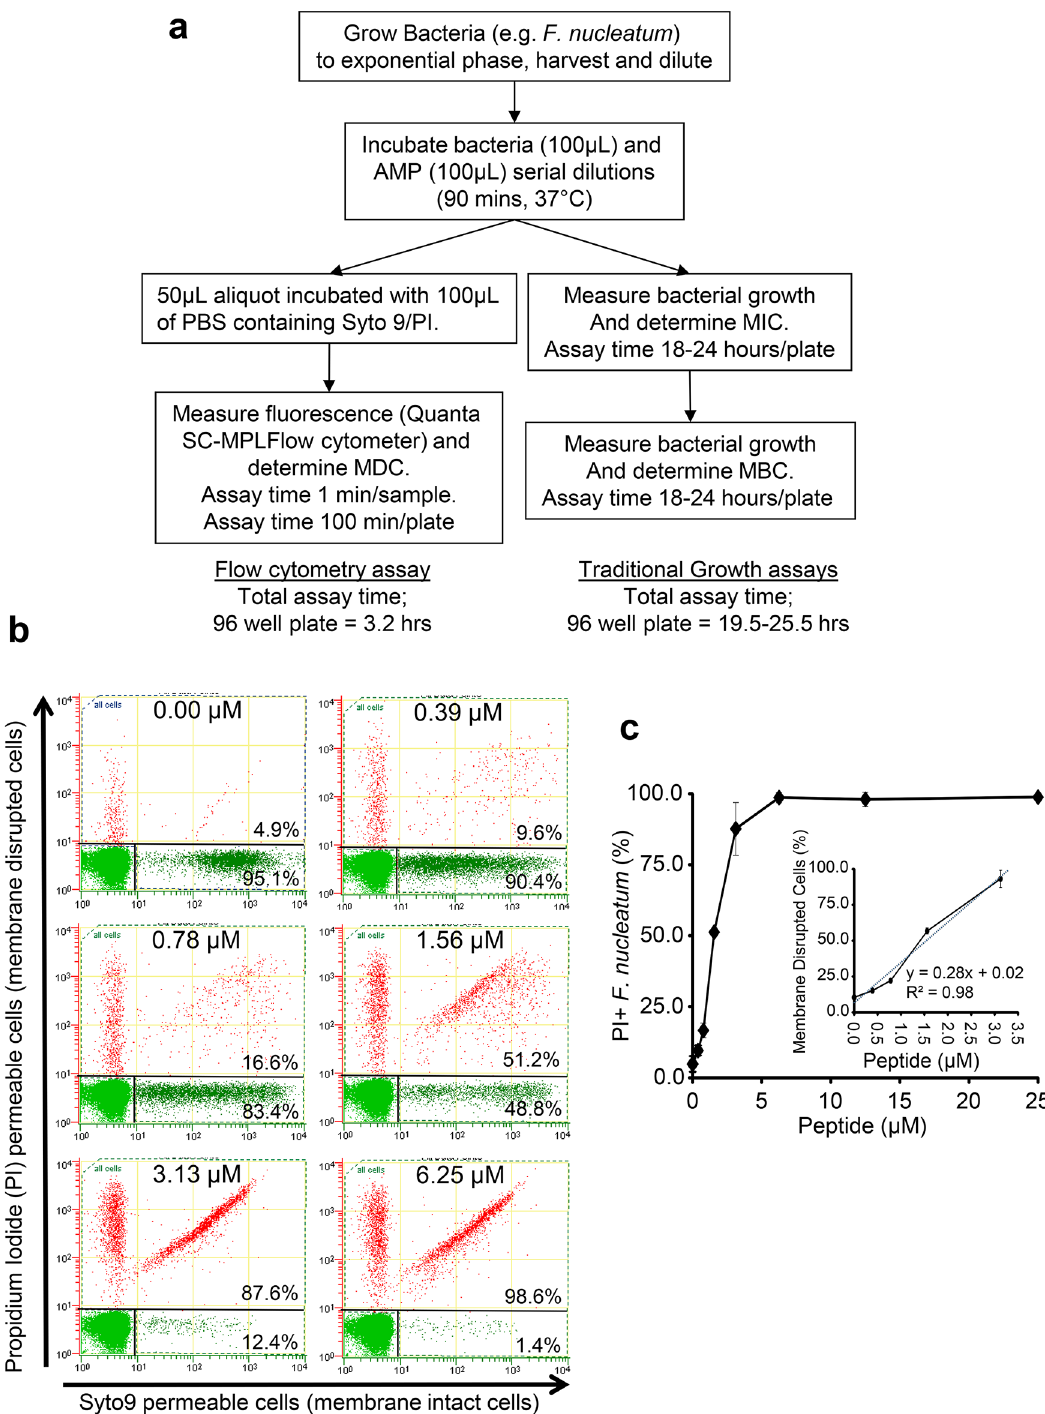
Fig 1. Increasing concentration of the antimicrobial peptide Melittin increases bacterial membrane permeability to propidium iodide. (a) Schematic representation of the work flow for determining MIC, MBC and MDC. (b) Flow cytometry dot blots of F . nucleatum incubated with increasing concentrations of Melittin and stained with Syto9 dye (membrane permeable) and propidium iodide dye (membrane impermeable). (c) Percent propidium iodide positive F . nucleatum cells correlates with increasing peptide concentration. Insert shows the reciprocal plot of percent membrane disrupted cells (PI+) and peptide concentration to determine